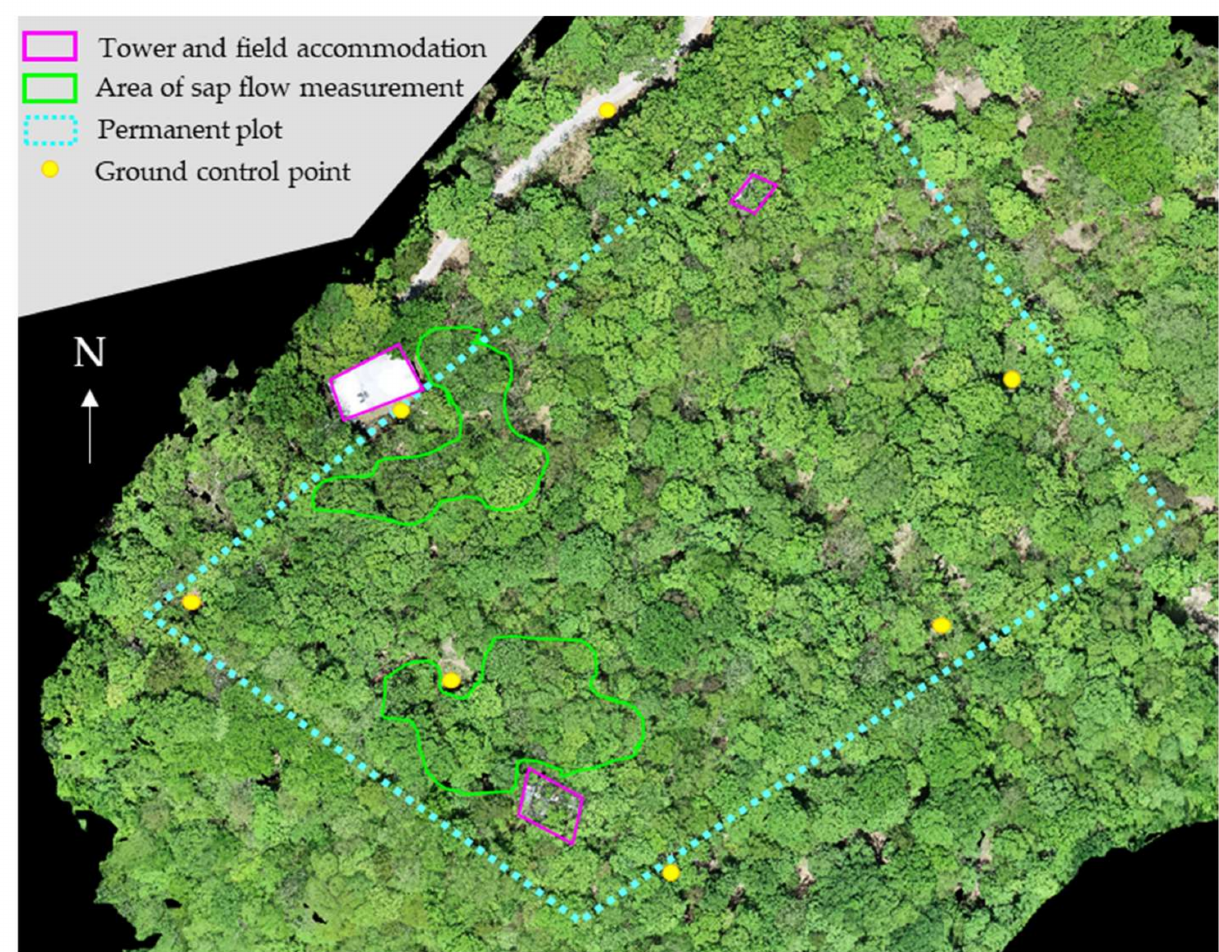
Figure A1. Orthophoto of the study site acquired on 25 May 2019 (DOY 145) showing location of ground control points, towers, and field accommodation and the area of sap flow